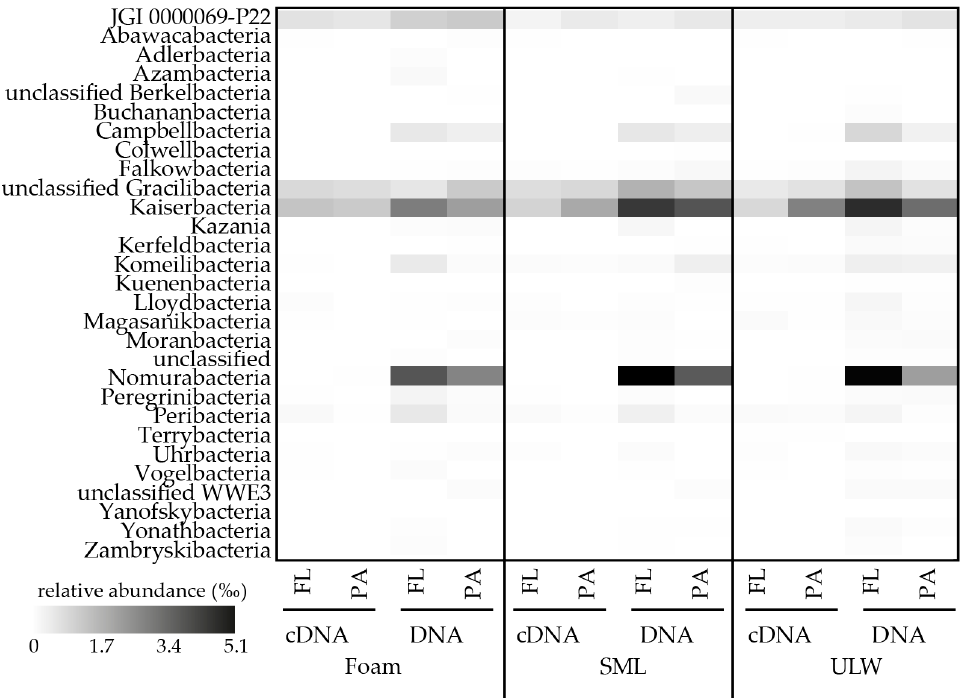
Figure 3. Heatmap showing relative abundance (‰) of patescibacterial candidate clades for cDNA and DNA-derived amplicons in foam, sea-surface microlayer (SML) and underlying water (ULW). Samples were further divided into free-living (FL) and particle-associated (PA) fractions. Only lineages with >10 reads are shown.